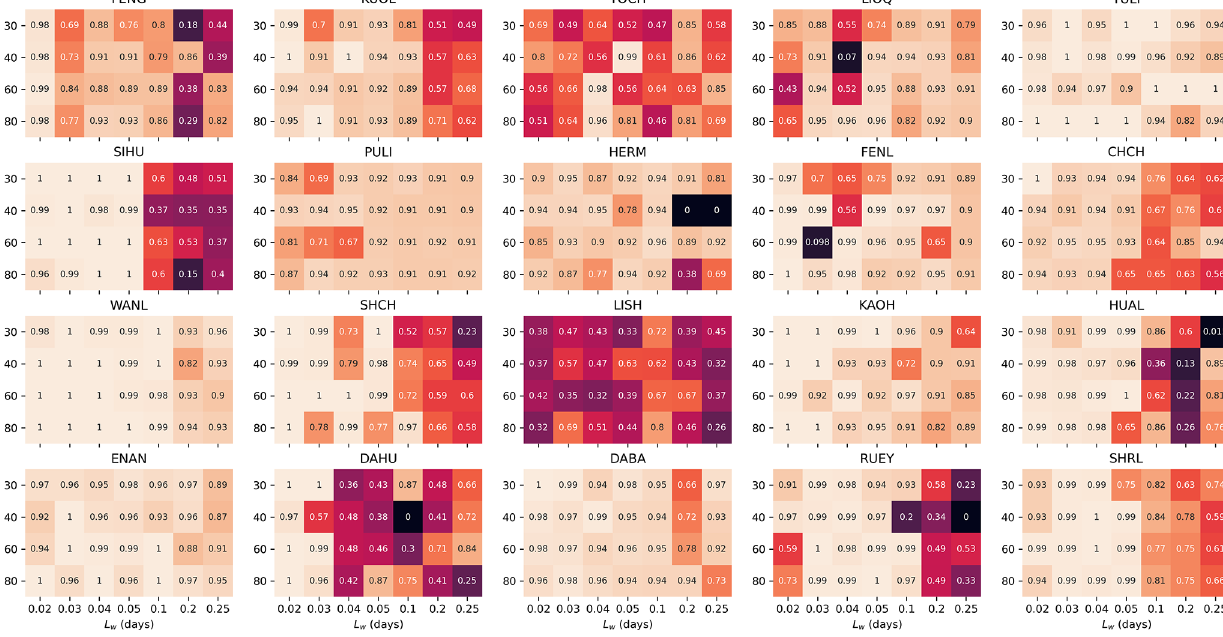
Figure 14. Heatmaps of GCL values for all 20 stations across tested hyperparameter space, given R D _min = 0 . 95.